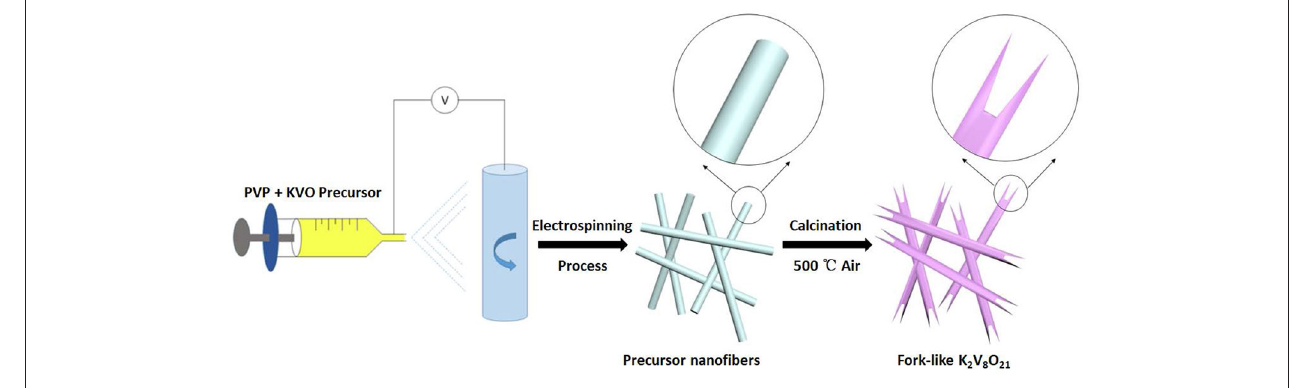
FIGURE 1 | Schematic illustration for the synthesis of fork-like K 2 V 8 O 21 .